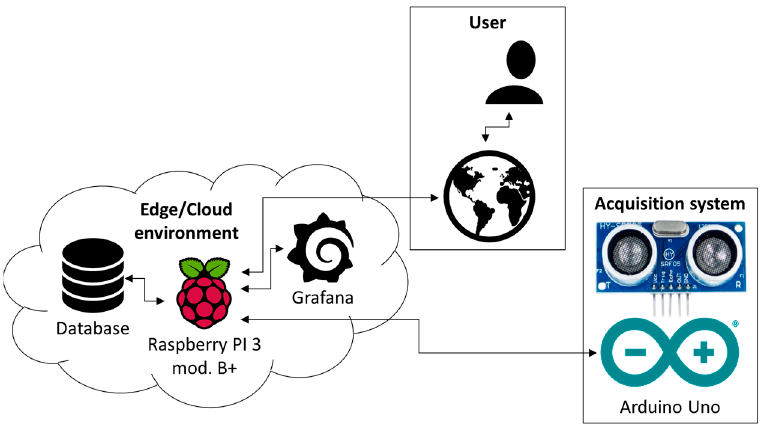
Figure 4. Representative scheme of the acquisition system in an Edge/Cloud environment.